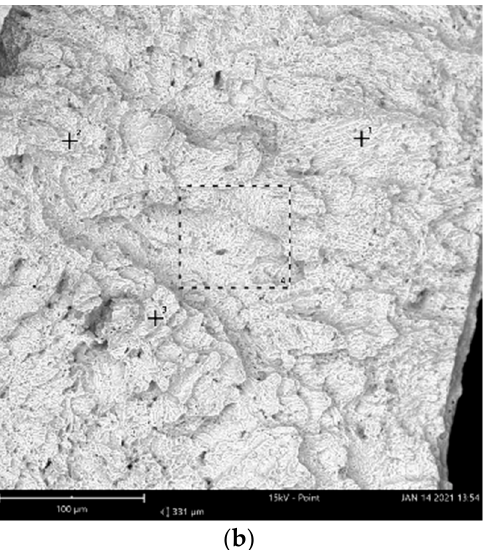
Figure 7. SEM internal defects on BTK ( a ) and BE ( b ) samples.